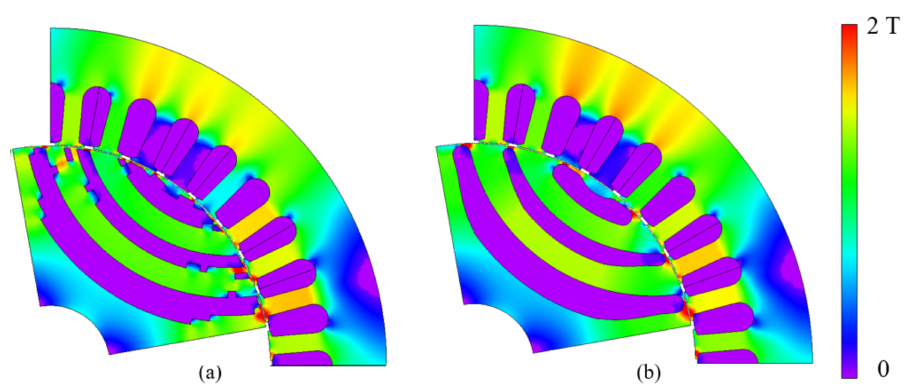
Figure 12. Comparison of magnetic flux density between. ( a ) ON-OFF result model and ( b ) model applying smoothing technique.